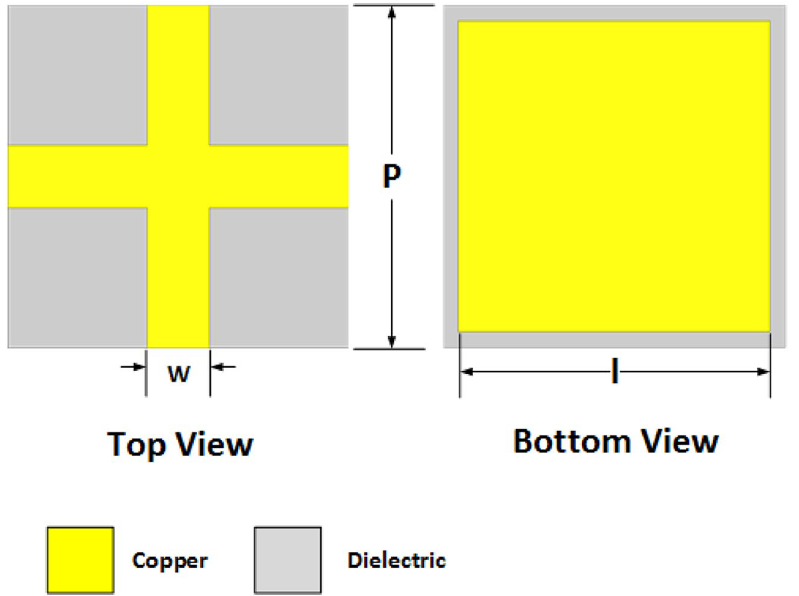
Figure 1. Unit cell of the proposed phase gradient